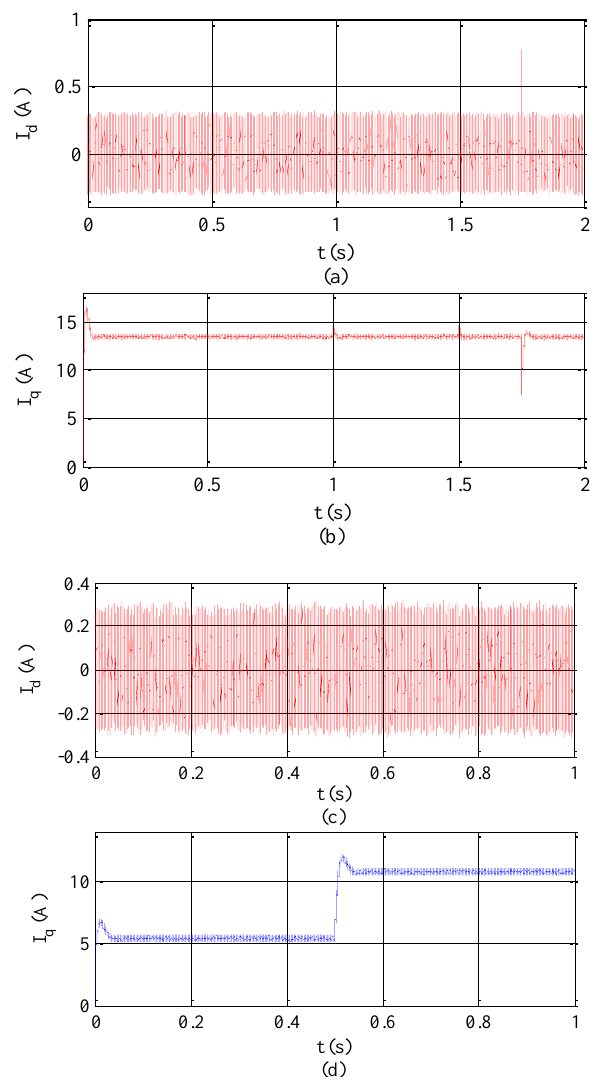
Figure 7. Waveforms of currents in d -axis and q -axis: ( a ) d -axis current with speed changes; ( b ) q -axis current with speed changes; ( c ) d -axis current with torque changes; ( d ) q -axis current with torque changes.